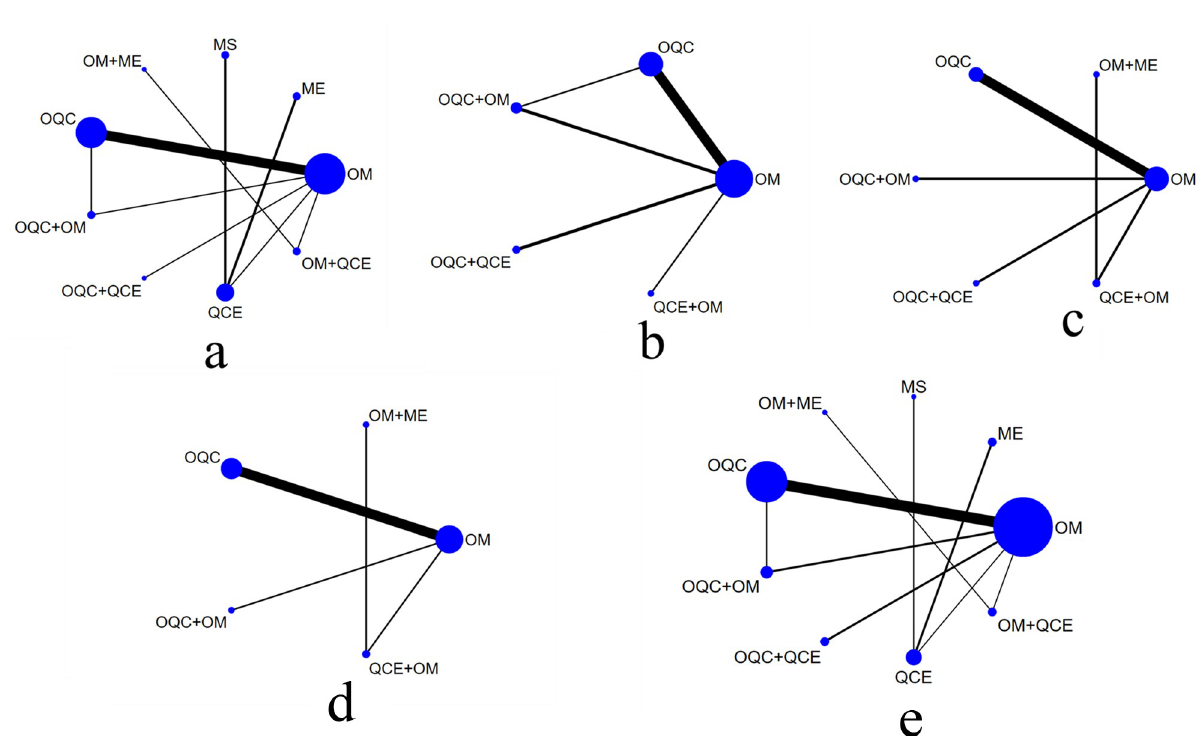
Fig 3. Network evidence of all endpoints. (a) Clinical response; (b) Improvement of Mayo scores; (c) Endoscopic improvement; (d) TCM syndrome integral; (e) Adverse effects. OM: Oral mesalazine; OQC: Oral Qingre-Chushi therapies; QCE: Qingre-Chushi therapies enema; ME: Mesalazine enema; MS: mesalazine suppository.